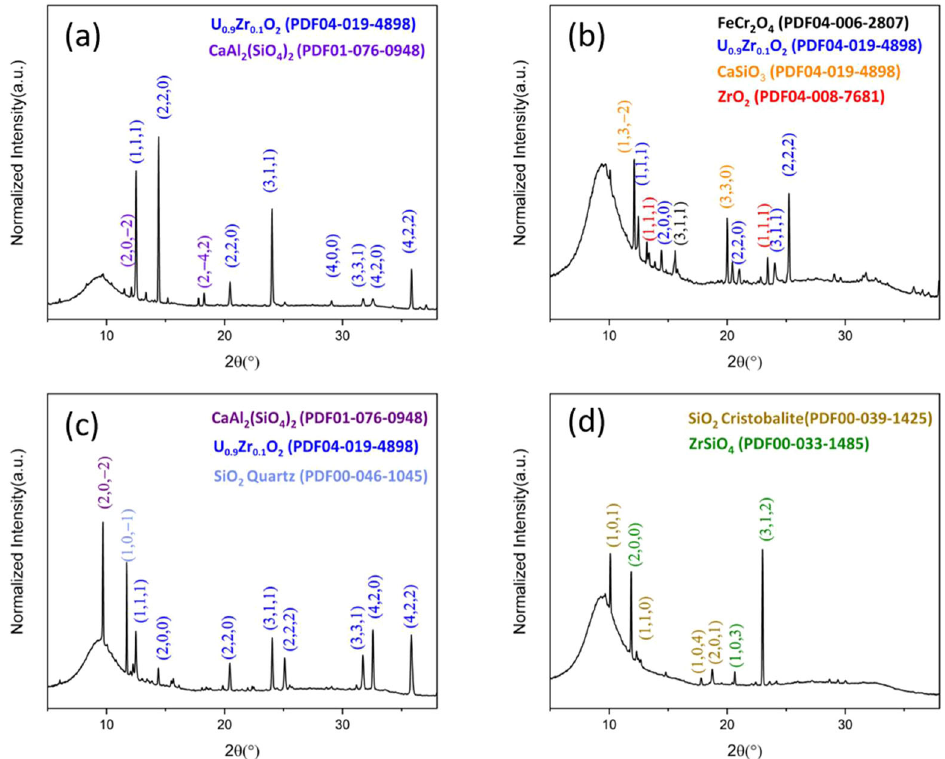
Fig. 6 Single pixel µ-diffraction patterns of silicate minerals present in MCCI. a anorthite; b CaSiO 3 ; c SiO 2 -quartz and d SiO 2